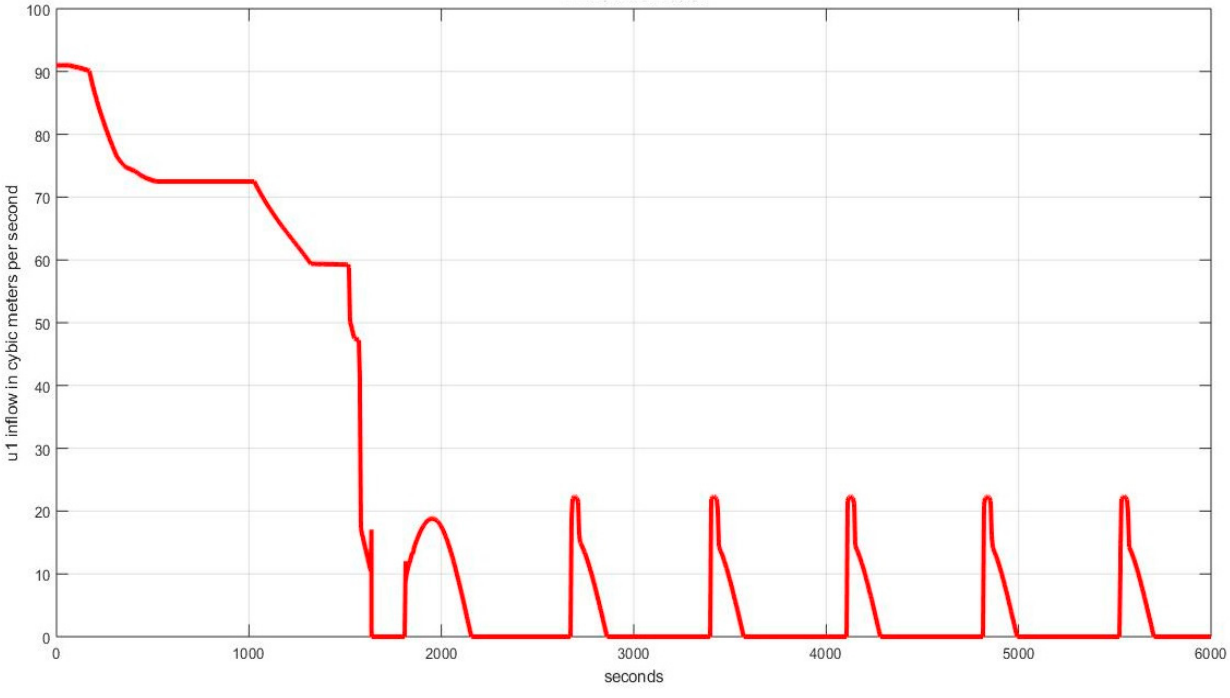
Figure 15. U1 control variable indicating the water inflow for case of sinusoidal disturbance.